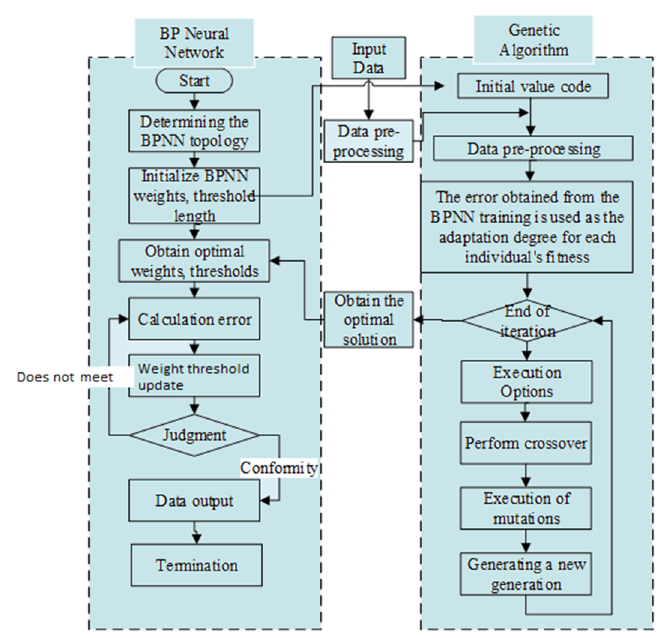
Figure 2. Flow chart of BP neural network improved by genetic algorithm.